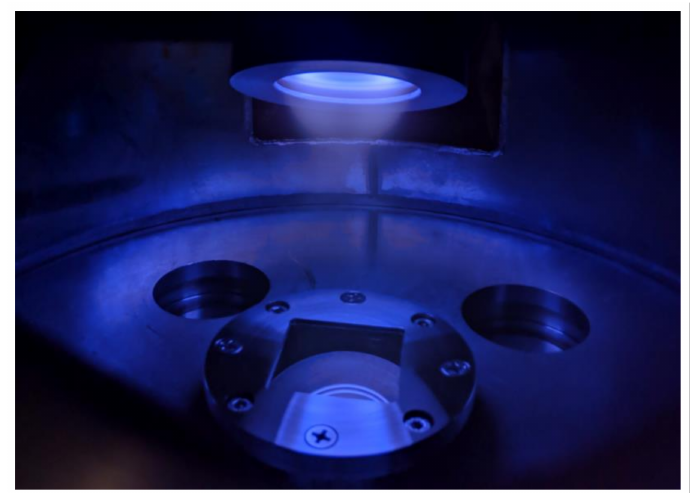
Figure 2. Photograph of the magnetron and the sample stage during the coating